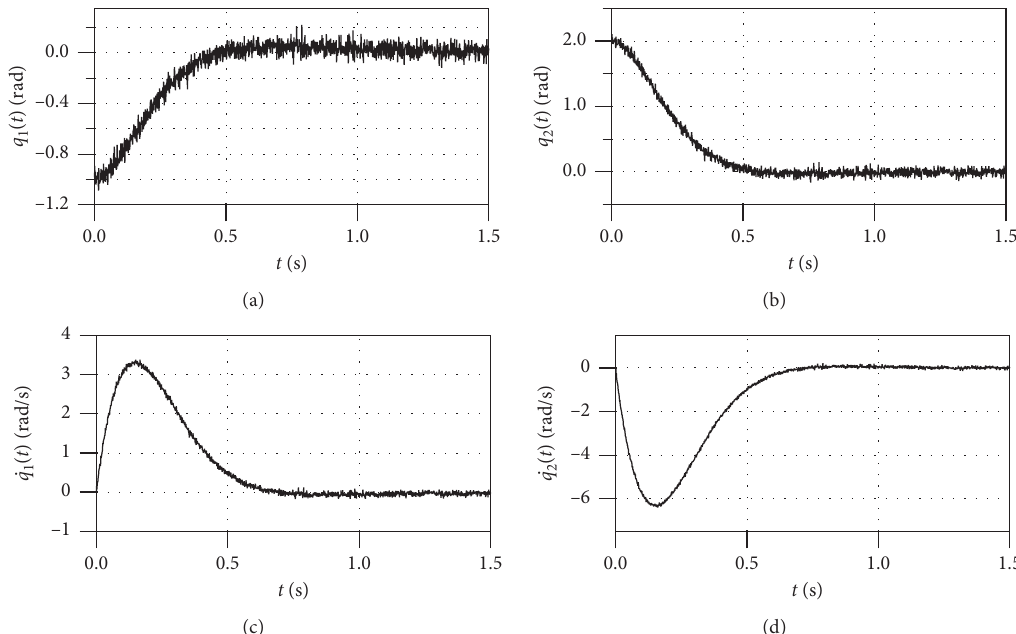
Figure 4: Time response of q exist.